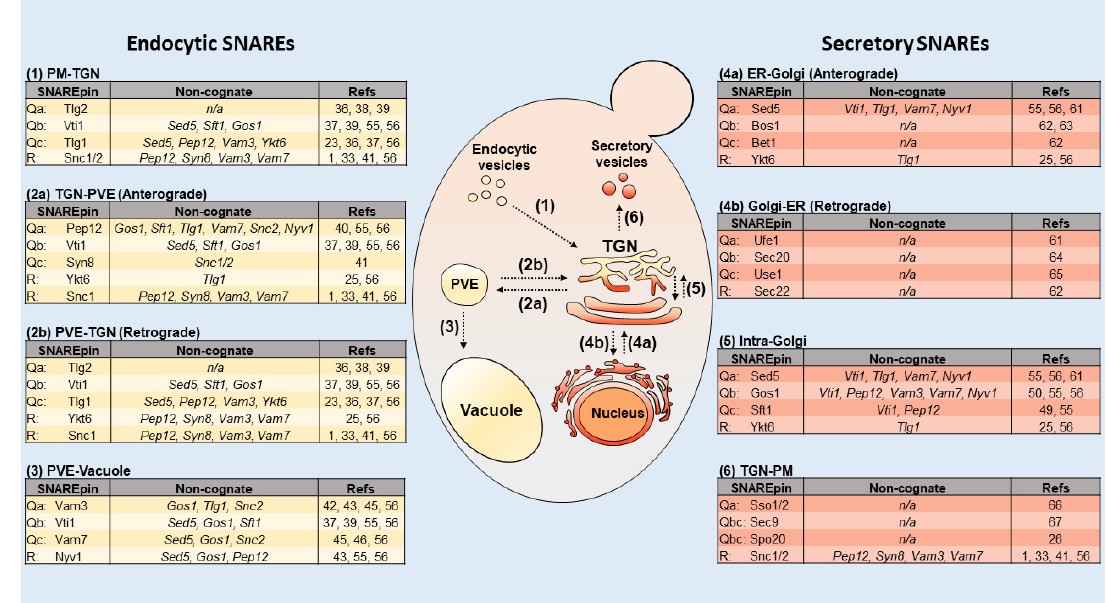
Figure 1. SNARE proteins in the yeast minimal endomembrane system. Center, a cartoon model depicting the yeast minimal endomembrane system. (1) In the endocytic pathway, vesicles fuse with the TGN, within 3 min post-internalization. (2) Cargo destined for degradation is trafficked to the PVE via associated sorting signals within 10 min post-internalization [16]. (2a-b) Cargo is bi-directionally trafficked between the PVE and TGN. (3) PVE cargo fuses to the vacuole for degradation within 30 min post-internalization. (4a-b) Proteins that are synthesized in the rough endoplasmic reticulum (RER) are trafficked to the Golgi. Newly synthesized proteins proceed to the TGN or are returned to the endoplasmic reticulum (ER). (5) Secretory proteins are packaged into vesicles and bud off the TGN. (6) Secretory vesicles fuse to the PM to release cargo. Moreover, v- and t-SNAREs are referred to as R-SNAREs and Q-SNAREs, respectively, due to the conserved arginine or glutamine residues found in the main interaction site of the SNAREpin core [20]. Q-SNAREs are further categorized as Qa-, Qb-, Qc- or Qbc-SNAREs, depending on the position of their SNARE motifs within the SNAREpin. Yellow indicates endocytic pathway and orange indicates the secretory pathway. Left and right tables indicate SNAREs that mediate specific fusion steps. Cognate and non-cognate interactions are also shown.